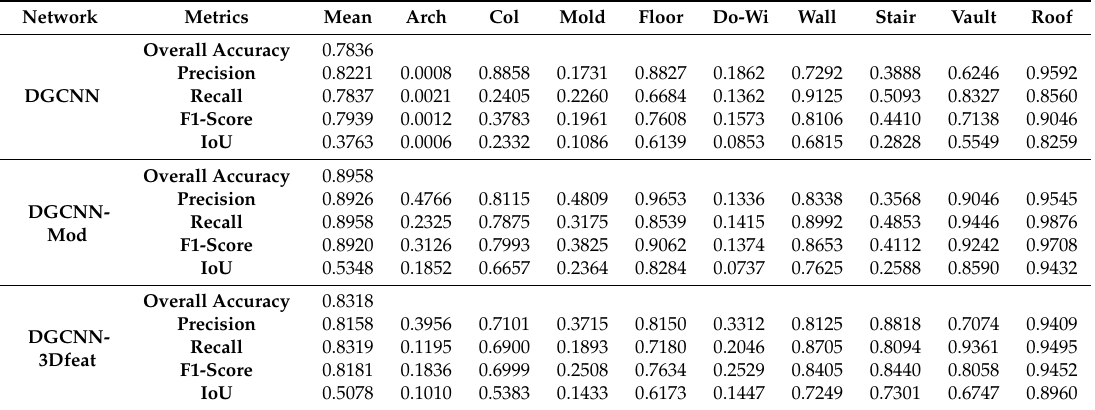
Table A5. Tests performed on the B_SMG scene, with the whole ArCH dataset as training. Fourteen scenes as training, 1 for validation (5_SMV_chapel_1) and 1 for